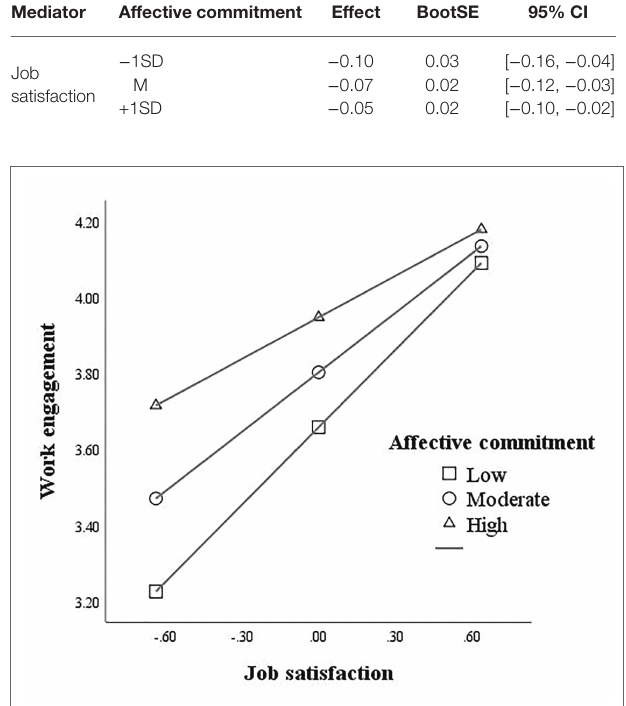
FIGURE 3 | Simple slopes.